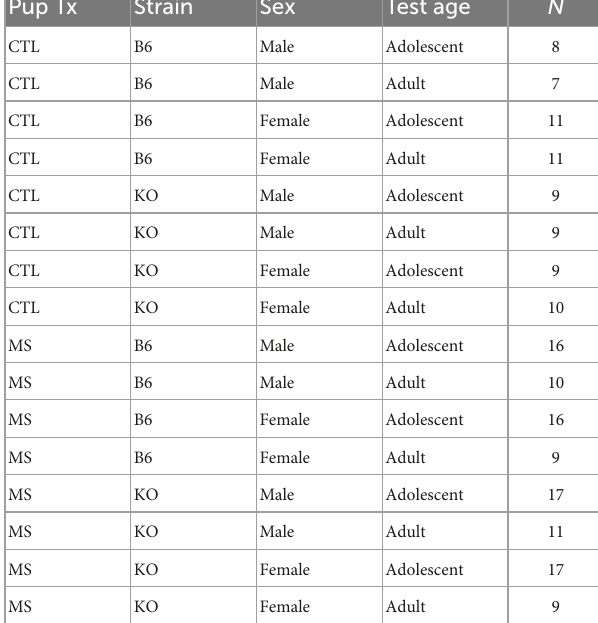
TABLE 1 The number of subjects in each of the 16 experimental